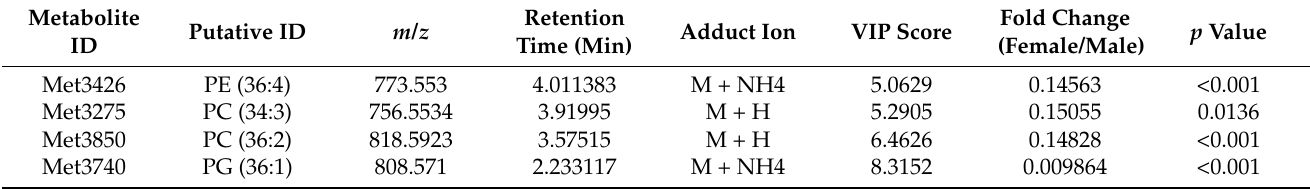
Table 6. The difference of lipidomics in MS-electrospray positive ion mode between female and male living liver donors.